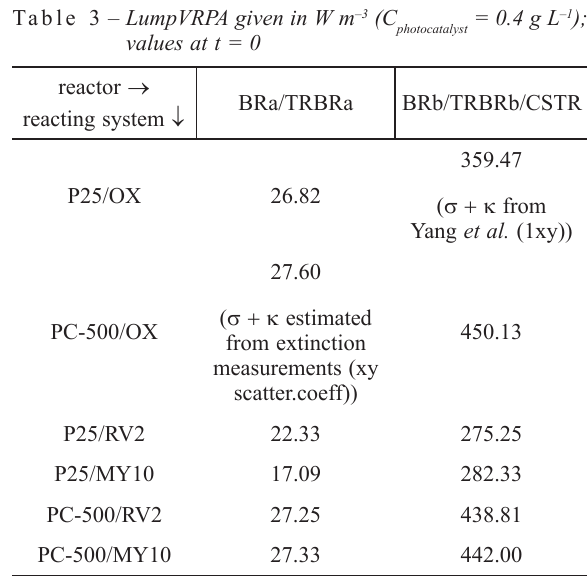
= 0.4 g L –1 photocatalyst